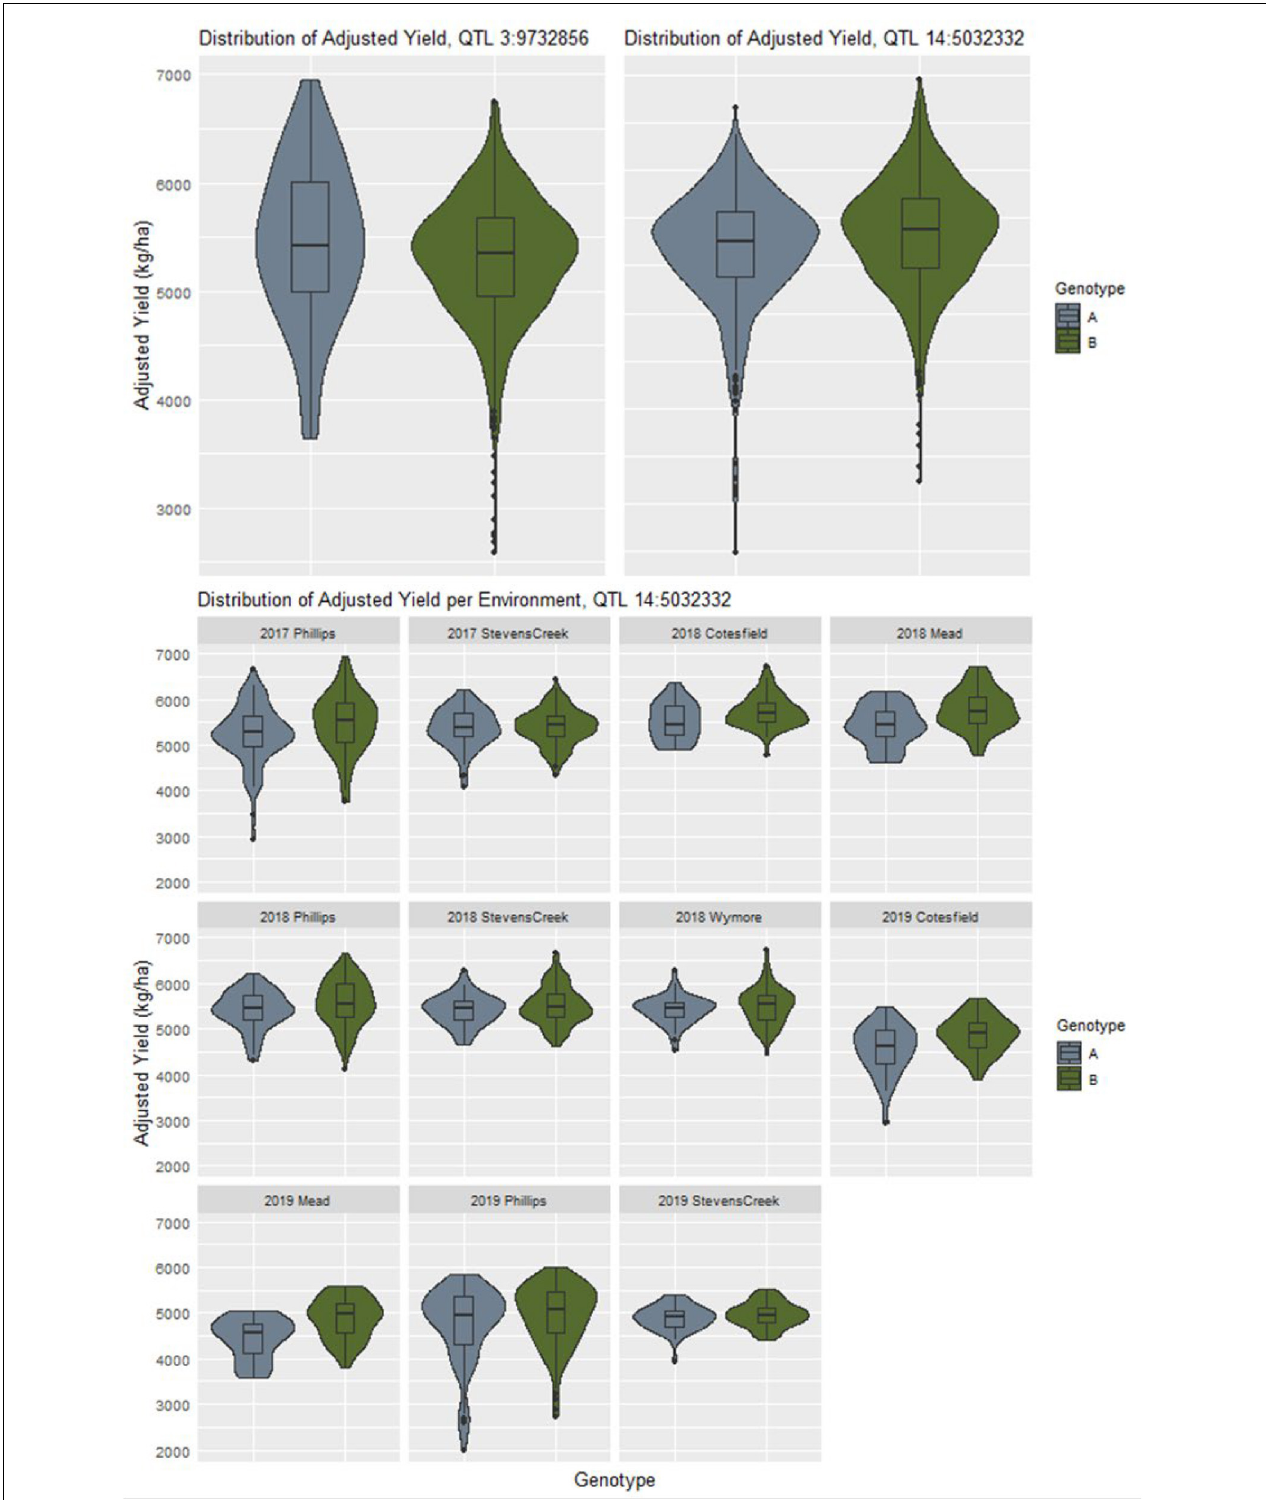
FIGURE 4 | The contrast in distribution of adjusted yield between allelic states at the QTL on chromosome 3 indicates a difference yield stability as compared to the QTL on chromosome 14 which initially appears to be falsely associated. However, when examining the adjusted yield from a per environment basis, differences in mean and spread according to specific site combinations become more